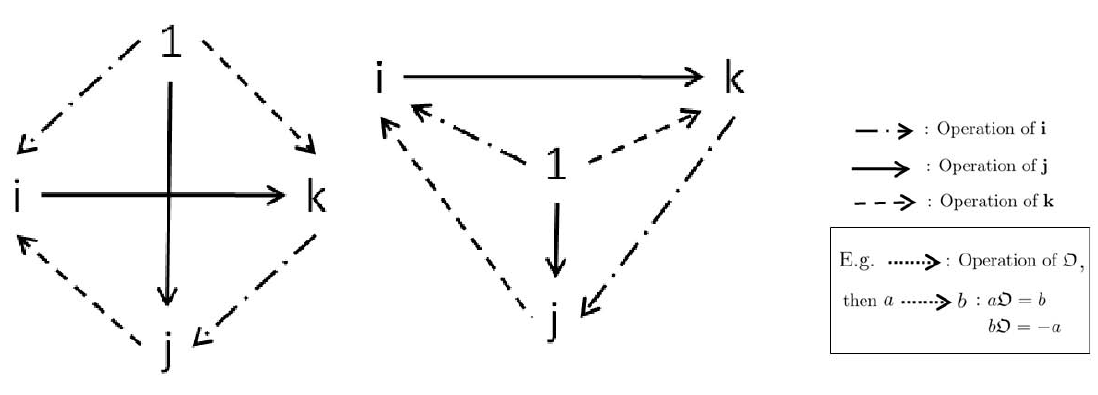
Figure 1. Two figures showing the result of using the quaternion basis as an operator set: only the array of elements is different.